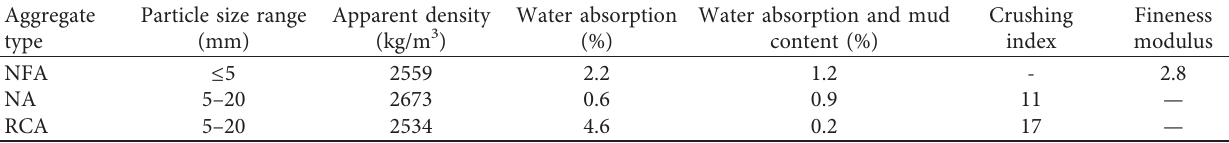
Table 1: Physical properties of aggregates.